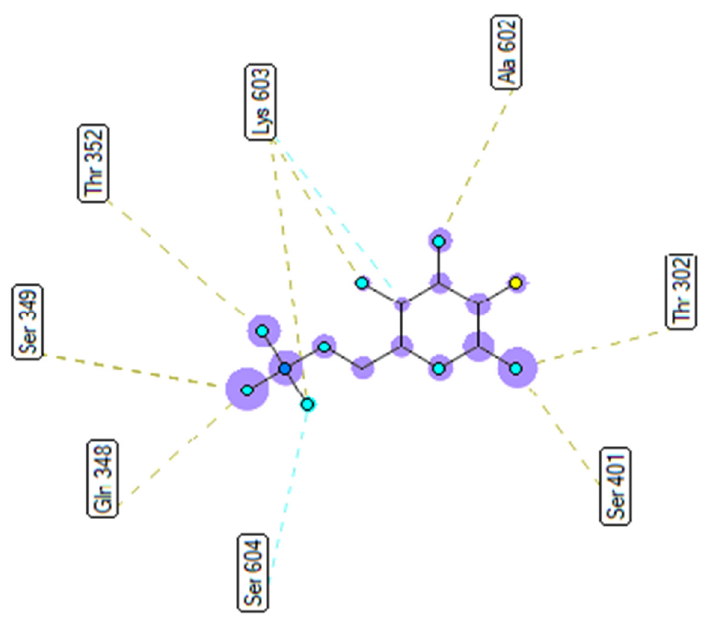
Figure 27. Ligand map showing the secondary interactions between pose 83, one small ligand, and enzyme 2VF5.